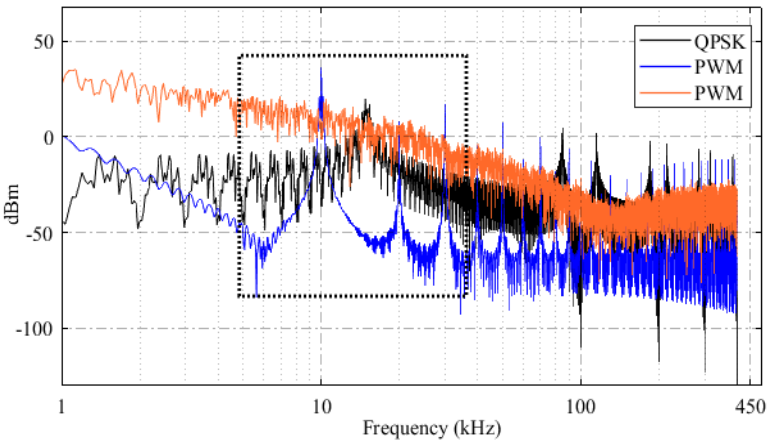
Figure 13. Voltage harmonics at the output of the DC-DC converter: PWM versus RPWM (10 kHz switching frequency) and frequency spectrum of QPSK modulated signal. The x-axis is in logarithmic scale.